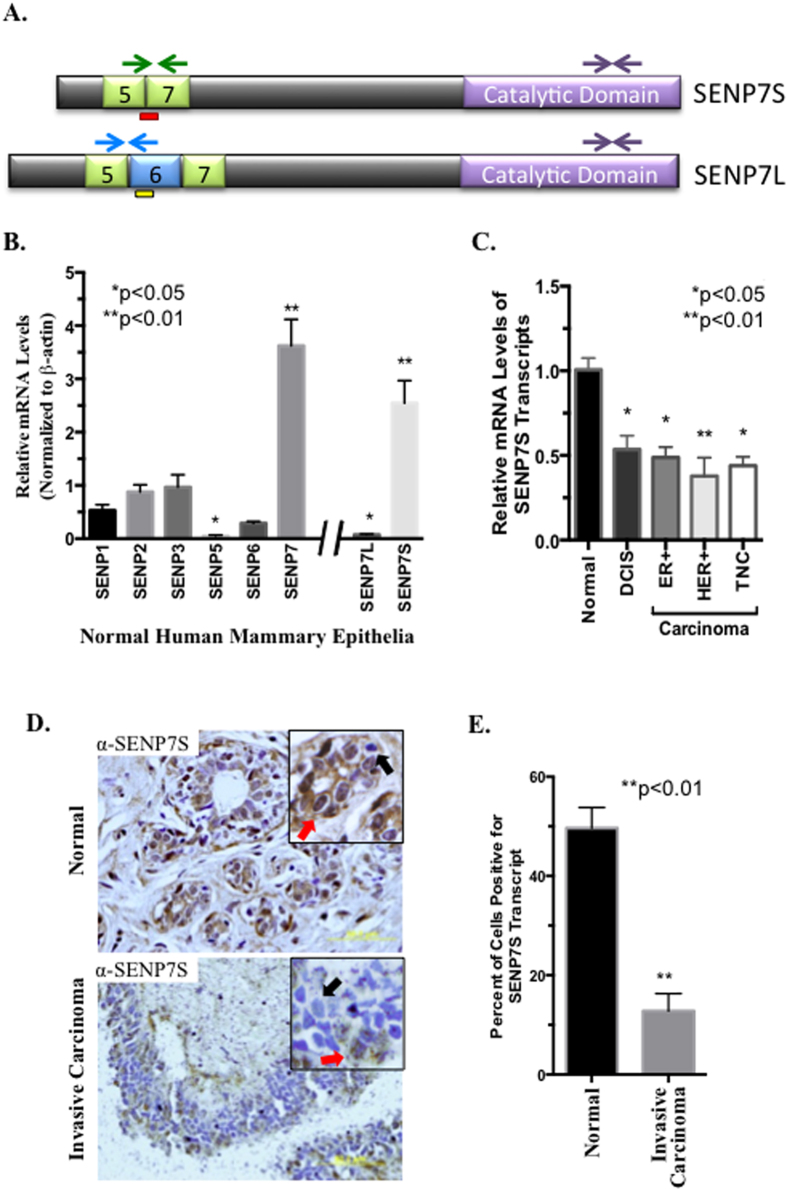
Inverse correlation of SENP7S and SENP7L isoforms in NME, DCIS, and multiple BCa subtypes.(A) Schematic illustrating SENP7S and SENP7L isoforms. Green arrows highlight primers for SENP7S, SENP7L-specific primers are indicated with blue arrows, and purple arrows represent primers that detect both isoforms. (B,C) Real-time PCR analysis of human patient samples in the TissueScan Breast Cancer Survey (Origene) was used to compare all SENPs in NME samples (n = 5, (B) or SENP7L and SENP7S in the indicated BCa subtype (n = 35 (C)). (B) Relative mRNA levels are normalized to the housekeeping gene β-actin and values on the y-axis represent 2−ΔCt times 104. (C) Relative mRNA levels are 2−ΔΔCt values and represents expression at a specific BCa type versus normal patient samples. ANOVA and Tukey’s post-hoc analysis and p-values (GraphPad) were based on raw ΔCt, and not 2ΔΔCt values. (D) SENP7S assessed in normal and carcinoma human tissue. IHC with SENP7S-specific antibody and hematoxylin counterstain was performed on human tissue samples (normal, n = 18 and carcinoma, n = 19). SENP7S-positive (red arrows) versus -negative (black arrows) cells are highlighted. (E) The graph represents the mean±SEM of the percent of SENP7S-positive to total cells in 40X images acquired from normal (n = 6) and carcinoma (n = 7).